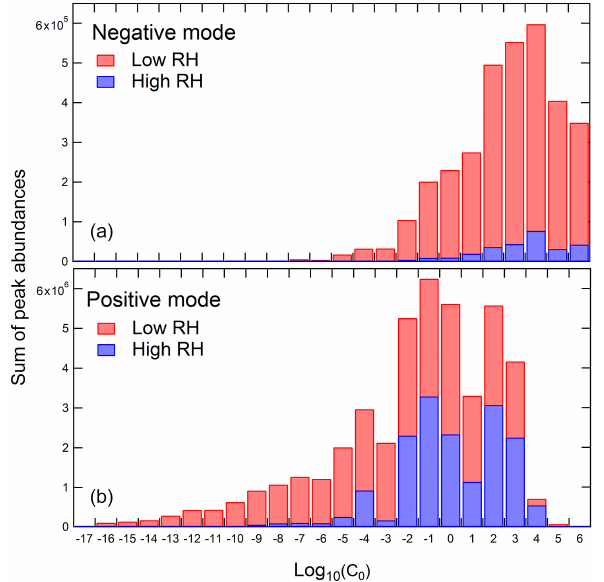
Figure 4. Examples of particle mass concentration measurements by SMPS (corrected for wall loss) as a function of photooxidation time under low-NO x (a) and high-NO x (b)